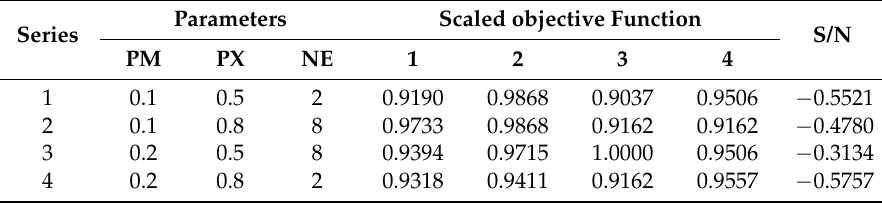
Table 4. Scaled outputs for the second stage according to L4 orthogonal table.